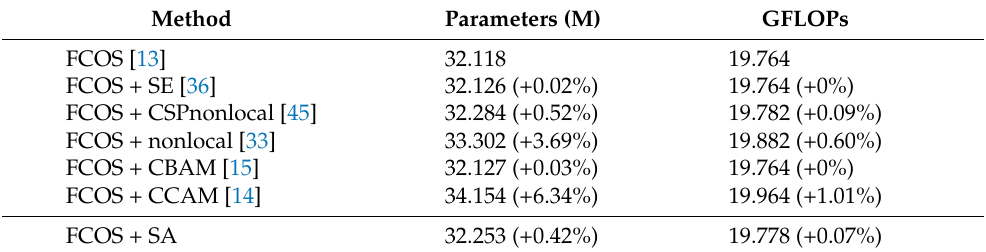
Table 18. The comparison results of attention modules in parameters and GFLOPs.